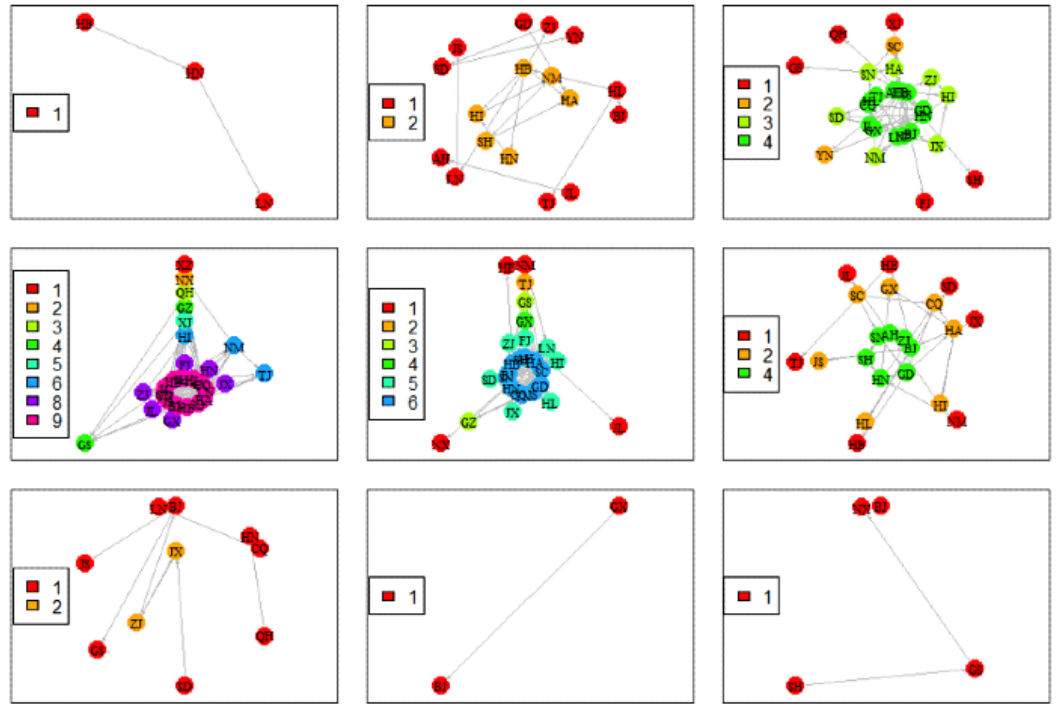
Figure 10. Dynamic networks of the COVID-19 epidemic showing the node composition and hierarchical structure. The color and label of each node denote the coreness and geographical province, respectively. The subgraphs from top to bottom and from left to right correspond to the nine weeks in order in the period from December 27, 2019 to February 25, 2020. AH: Anhui; BJ: Beijing; CQ: Chongqing; FJ: Fujian; GD: Guangdong; GS: